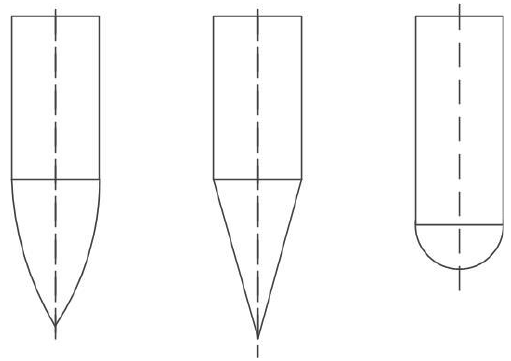
Figure 1. Different harpoon head shapes. The penetration capability of three different harpoon head shapes (oval head, tapered head and hemispherical head) was compared, and the oval harpoon head with the best penetration performance was obtained [17]. The residual velocity of the ovoid harpoon